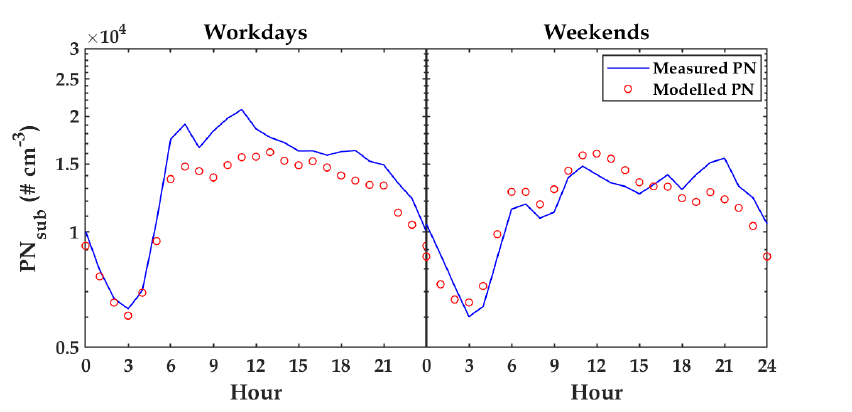
Figure 13. The median of diurnal cycles calculated on workdays and weekends for measured PN and modeled PN (No.